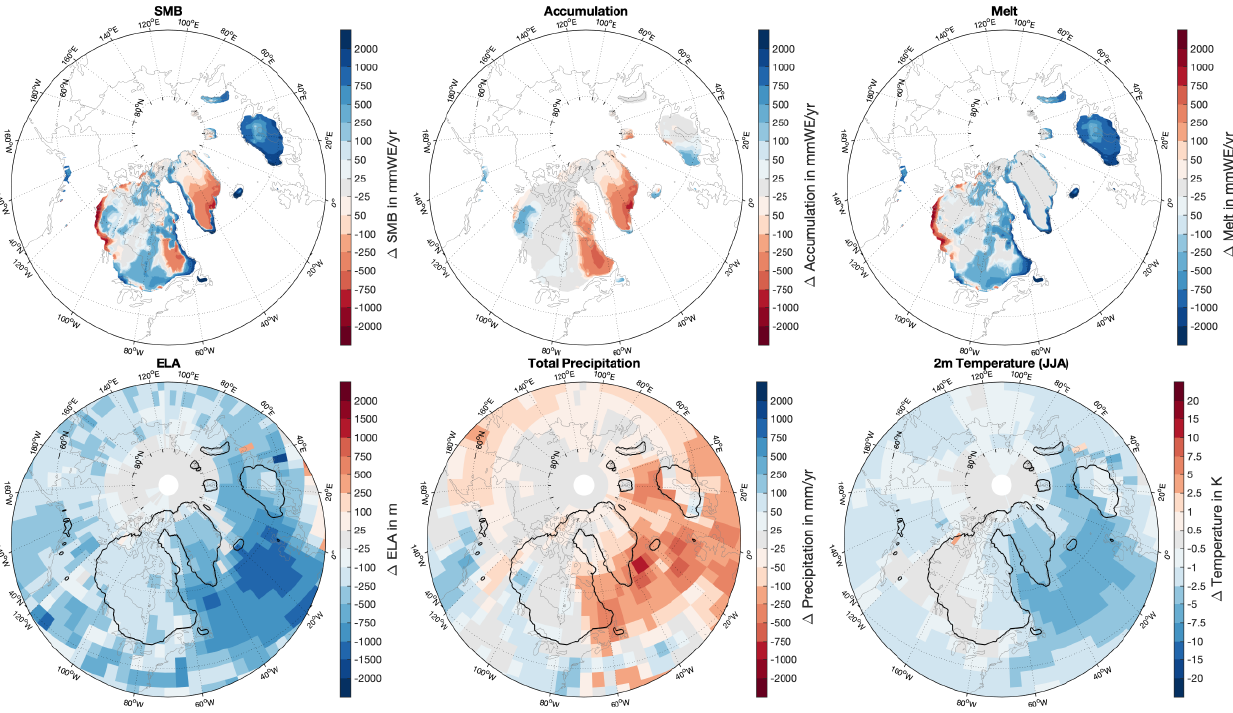
Figure A5. Similar to Fig. A3 but for differences between 11.2 and 12.2ka from MPI-ESM-CR Ice6G . Note that a different time slice was chosen compared to Fig. 7 due to different timings of the AMOC slowdown in MPI-ESM-CR Ice6G compared to MPI-ESM-CR Glac1D .